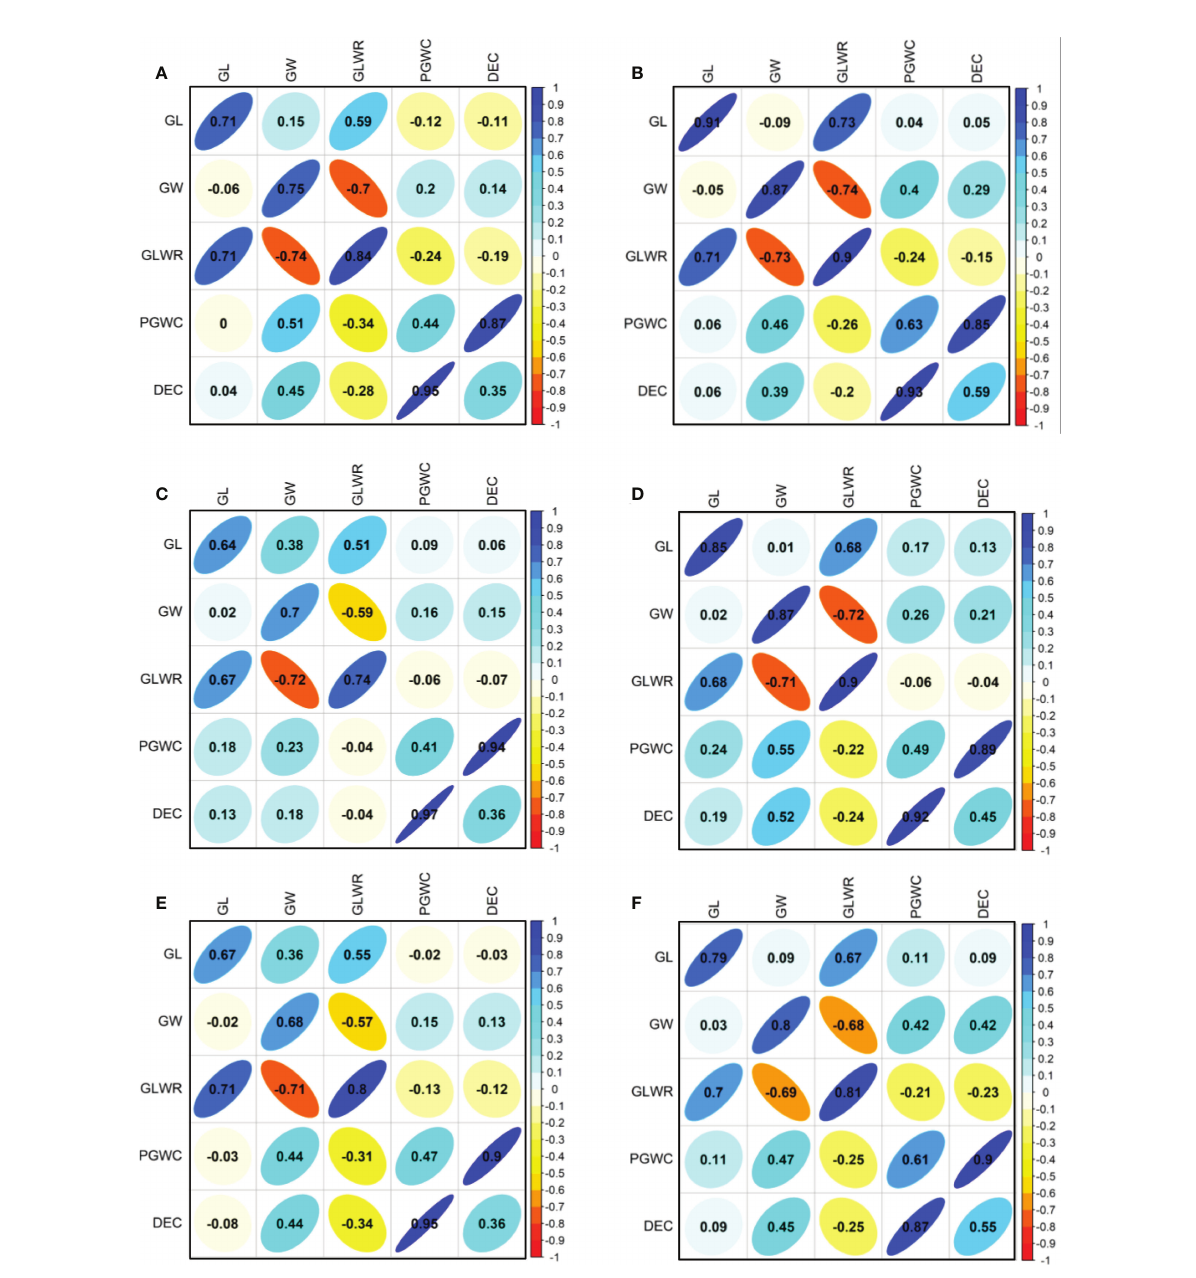
FIGURE 2 Correlations between fi ve evaluated traits in 2015 (lower triangular) and 2016 (upper triangular). (A, B) Represent DC1 population in PX and SZ, respectively; (C, D) Represent DC2 population in PX and SZ, respectively; (E, F) Represent 8way population in PX and SZ, respectively. The values on principal diagonal indicated correlations between 2015 and 2016. The values were correlation coef fi cients (r). The areas and colors of ellipses showed the absolute value of corresponding r. Right and left oblique ellipses indicated positive and negative correlations,